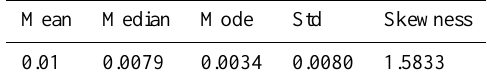
Fig. 1. Normalized histogram (blue bar chart) and fitted beta distri- bution (red curve) for ambient concentration (GOM+PBM). Table 1. Fitted beta distribution of the dry ambient concentration.